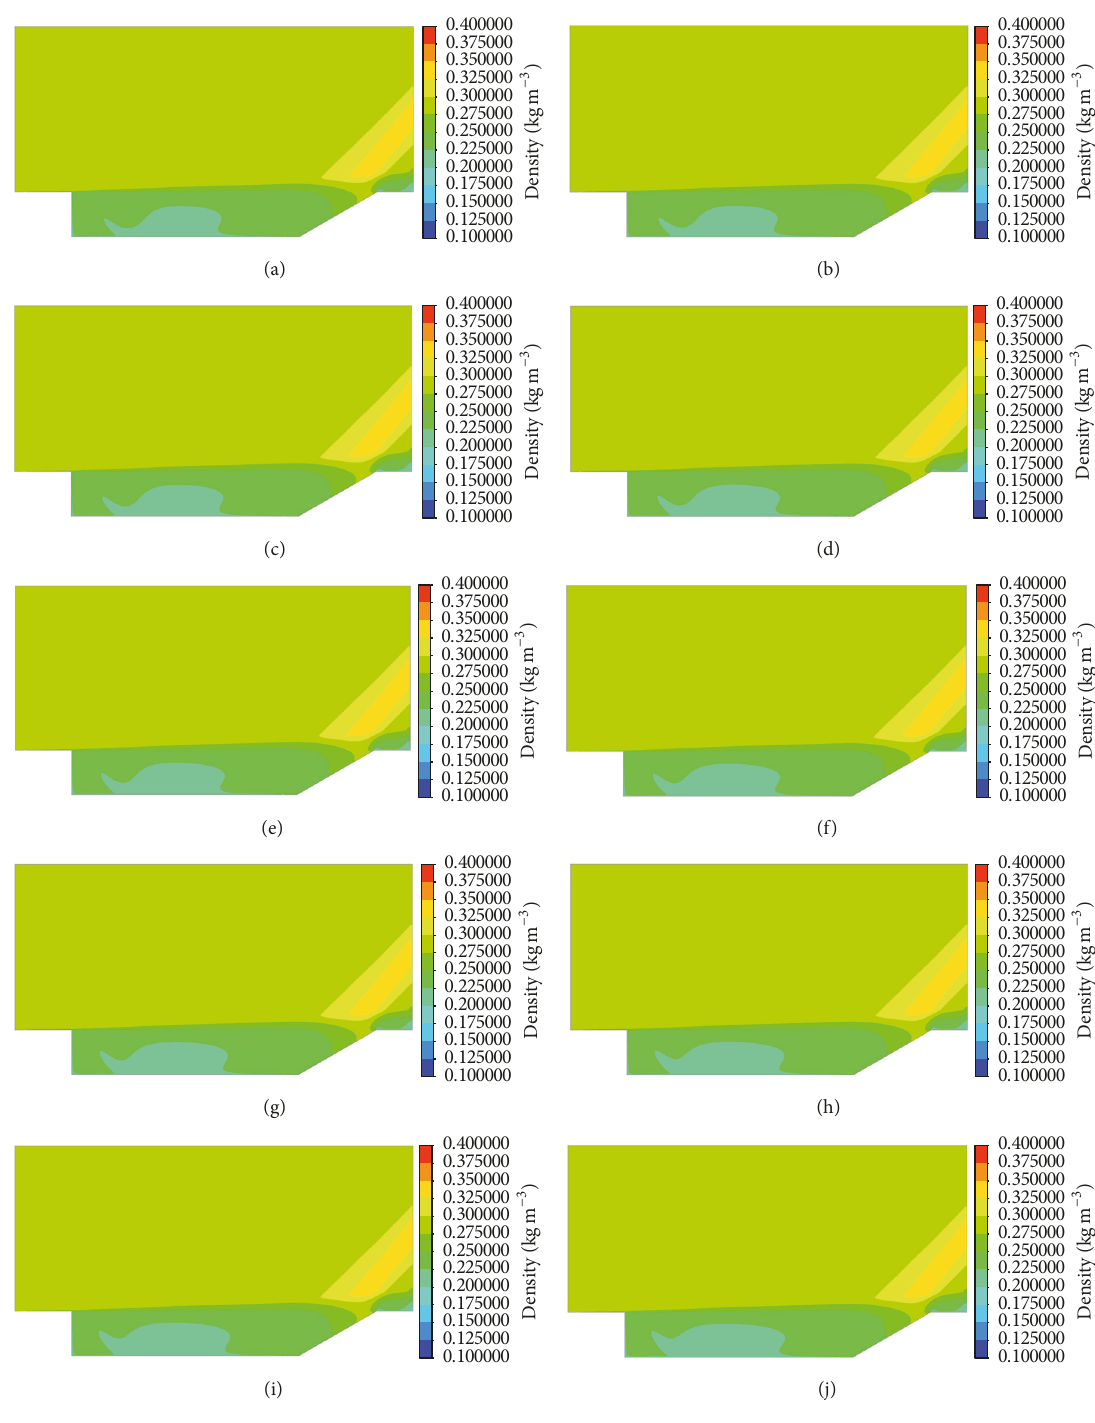
Figure 21: Density contours for TWM3 case (a) 𝑡/𝑡 𝑅 = 0 , (b) 𝑡/𝑡 𝑅 = 0.11 , (c) 𝑡/𝑡 𝑅 = 0.22 , (d) 𝑡/𝑡 𝑅 = 0.33 , (e) 𝑡/𝑡 𝑅 = 0.44 , (f) 𝑡/𝑡 𝑅 = 0.55 , (g) 𝑡/𝑡 = 0.66 , (h) 𝑡/𝑡 = 0.77 , (i) 𝑡/𝑡 = 0.88 , and (j) 𝑡/𝑡 = 1 . 𝑅 𝑅 𝑅 𝑅 whereas passive control methods are more effective; but they are not adjustable. Once implemented, they cannot be changed during